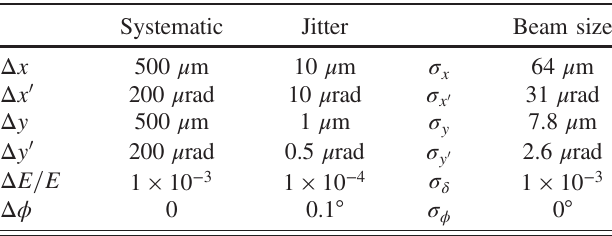
TABLE IV. Storage ring injected-beam rms systematic and jitter errors and rms injected beam sizes.